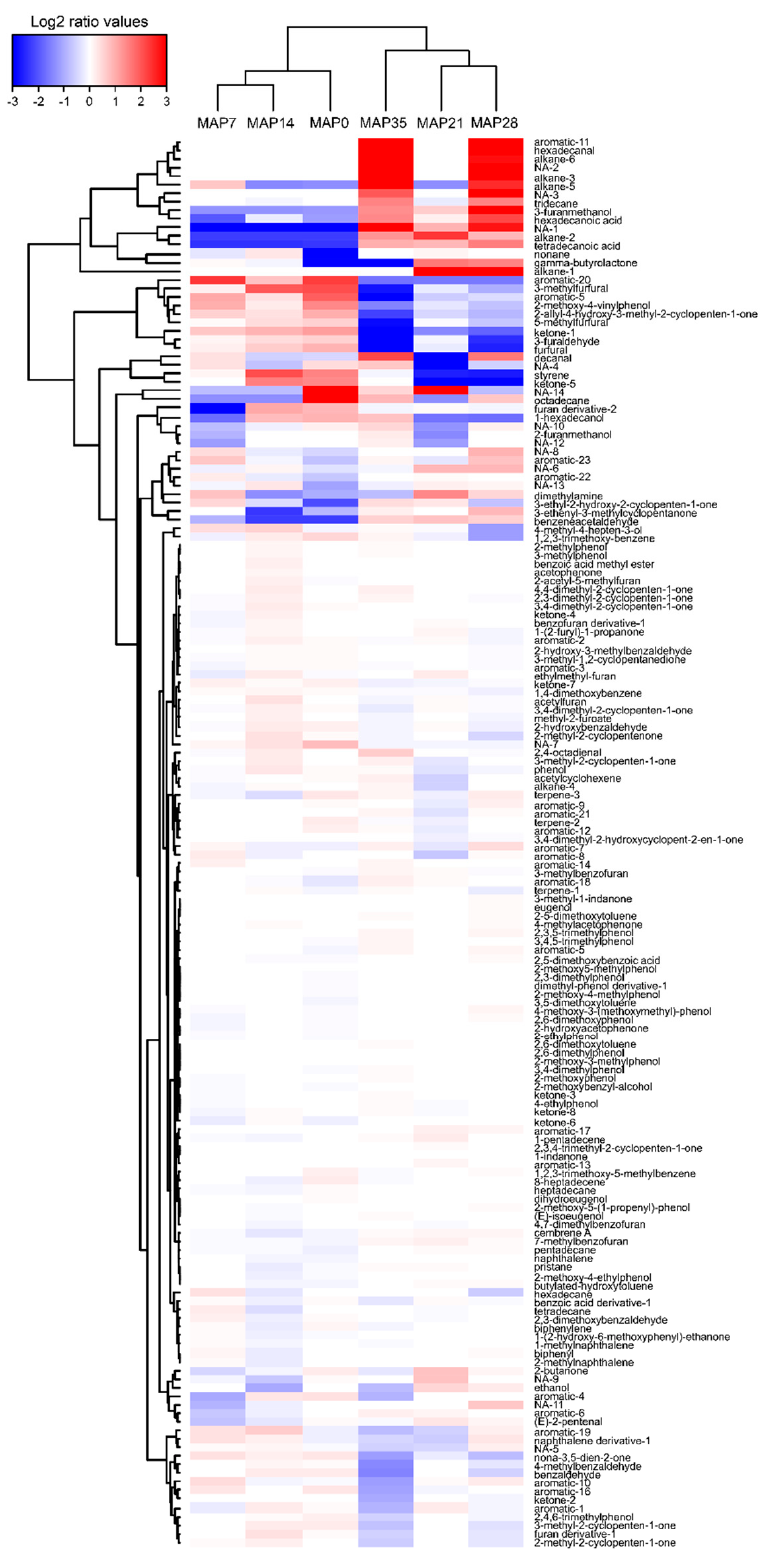
Figure 7. MAP CSS VOC hierarchical cluster analysis (HCA) heatmap based on the Euclidean distance calculated from a log 2 (n) transformation of the mean concentration (n = 3) amended by the median. The sampling time points are represented in columns (0 to 35 days), while the VOCs are depicted in rows. Blue colors indicate lower metabolite concentrations, while red colors show higher metabolite levels. See Supplementary Table S1.